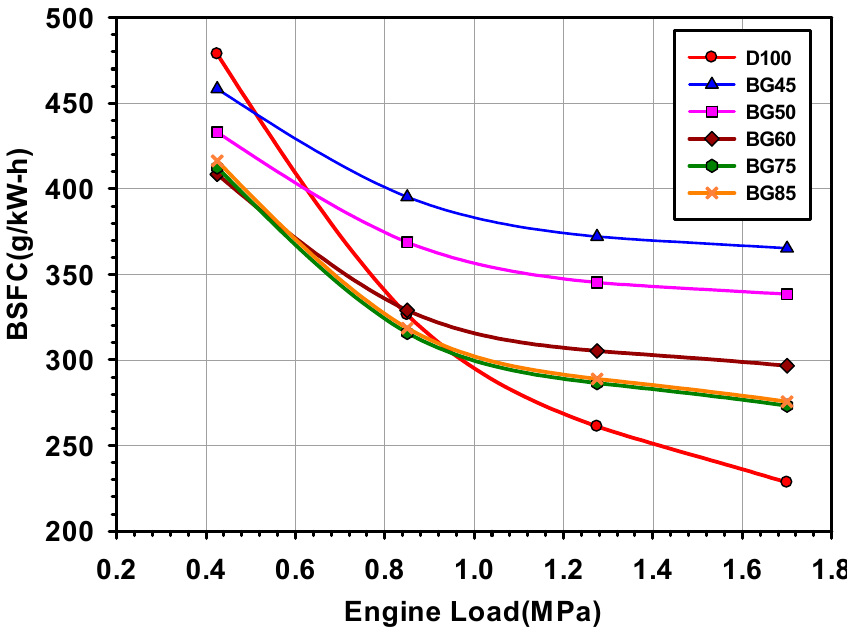
Figure 6. Variations of BSFCS with engine load for D100 and biogas-diesel fuels.